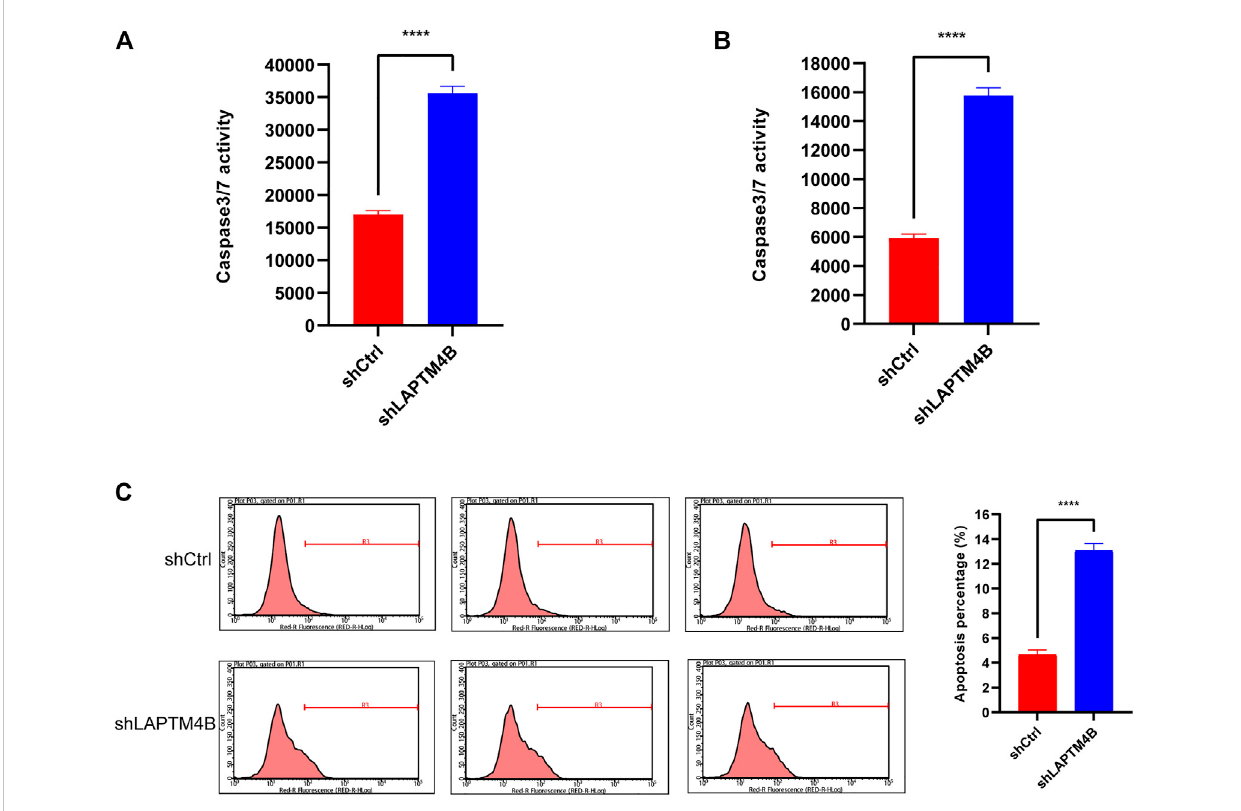
FIGURE 8 Knockdown of LAPTM4B induces apoptosis. (A) Caspase3/7 activity in 786-O. (B) Caspase3/7 activity in ACHN. (C) After the LAPTM4B knockdown, 786-O cells undergoing apoptosis increased signi fi